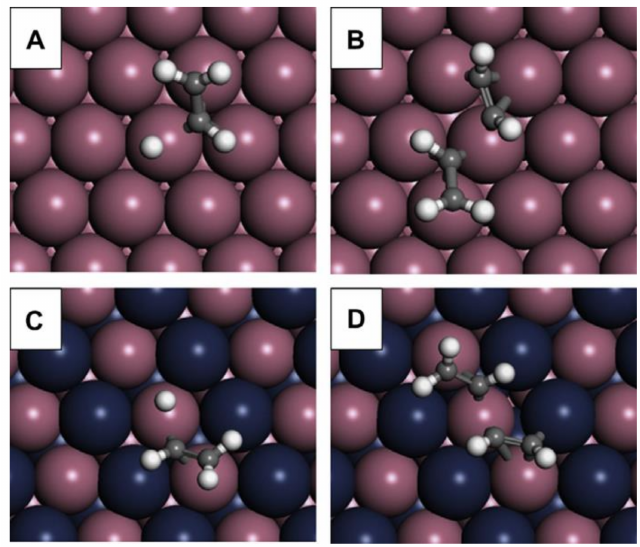
Figure 24. Transition states for vinyl hydrogenation and C–C bond formation on Ni(111) ( A and B ) and NiZn(101) ( C and D ), respectively. Ni atoms are light pink and Zn atoms are dark blue (reproduced with permission from [294]. Copyright 2014 Elsevier